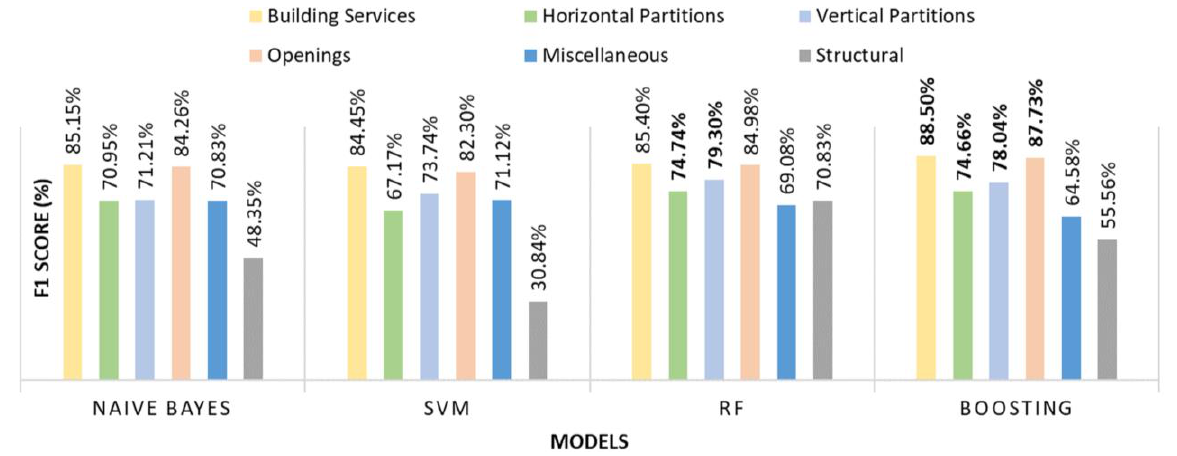
Figure 11. F1 score results.